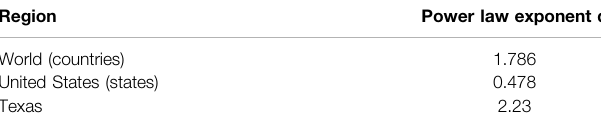
TABLE 3 | Distribution of cases per capita obey power laws.